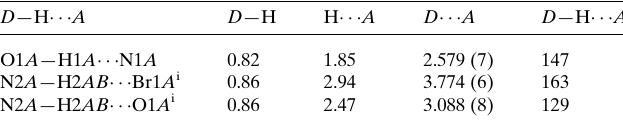
Table 1 Hydrogen-bond geometry (A˚ , (cid:5) ).